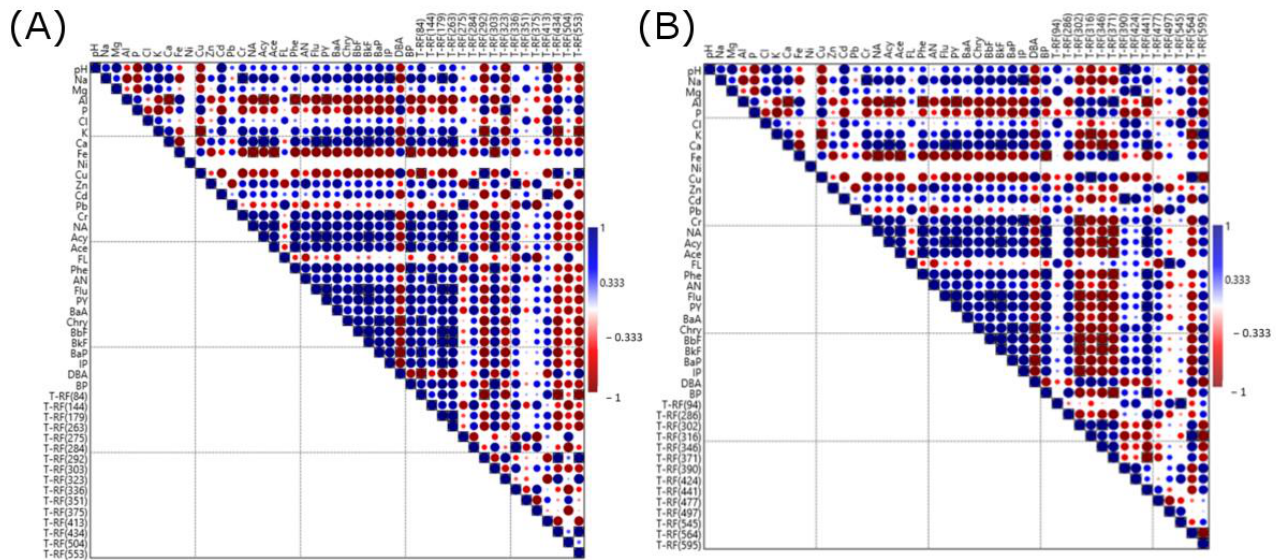
Figure 5. Pearson’s correlation analysis between the main properties of soil and TRFs defined for bacteria ( A ) and fungi ( B ). The boxed points correspond with significance correlation at p < 0.05.